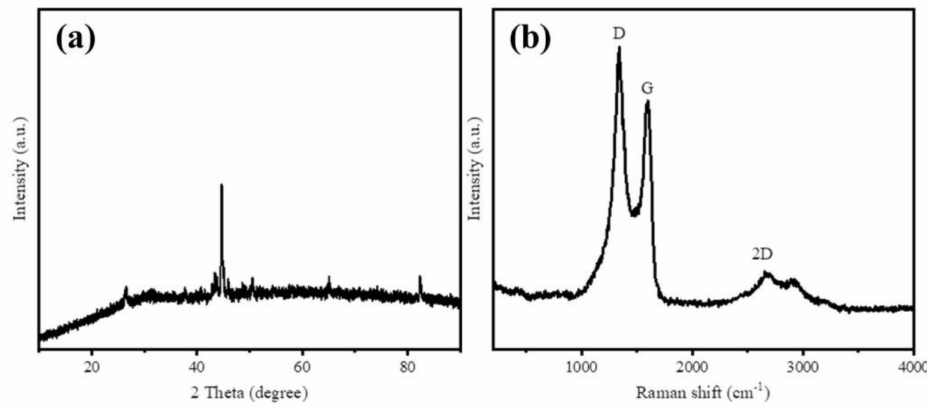
Figure 3. ( a ) X-ray di ff raction (XRD) patterns and ( b ) Raman spectra of Fe@BC.